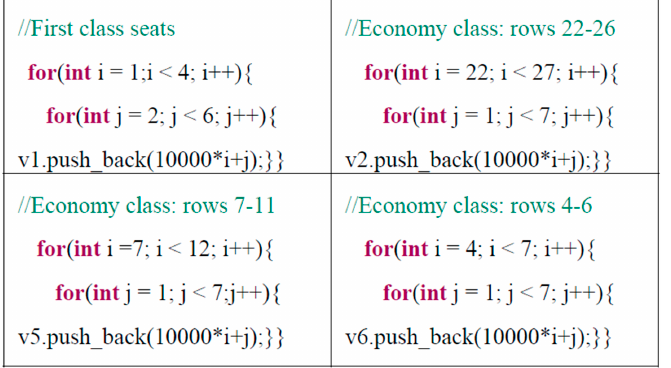
Figure 10. Random strategy seat number generation.